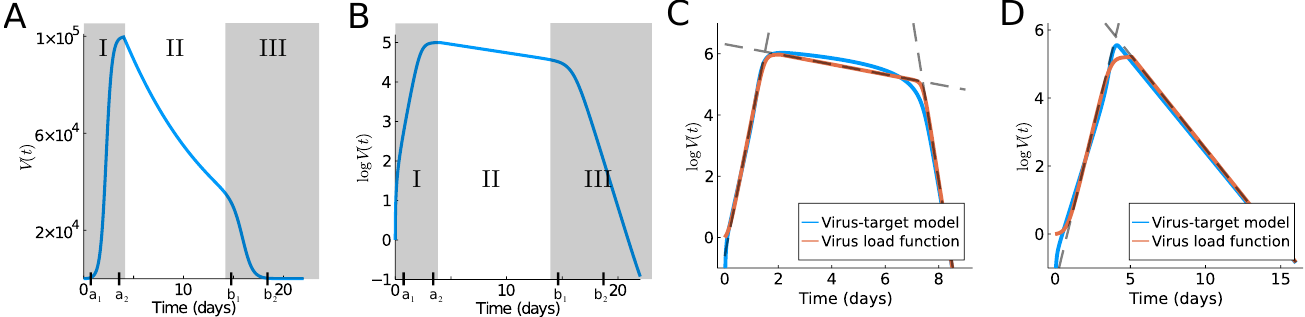
Figure 1. Typical virus load curves. The virus load (“titer”) is usually reported as a dilution value, TCID50, that is needed to infect 50% of a given cell culture in ( A ) absolute scale and ( B ) logarithmic scale. Shadow areas indicate the three phases into which we divide the virus load progression. Phase I describes the initial increase until a maximum is reached, Phase II denotes intermediate decay and Phase III, virus clearance. Images ( C , D ) show a comparison of the various models considered in this paper, where ( C ) shows a tri-phasic response and ( D ), a bi-phasic response. The red line shows the virus load function (1), the blue line, the corresponding solution of the target model ODE (9). The dashed lines indicate the linear approximations of the various phases, where phase I and III are computed by (8). Parameter values are given in Tables 1 and